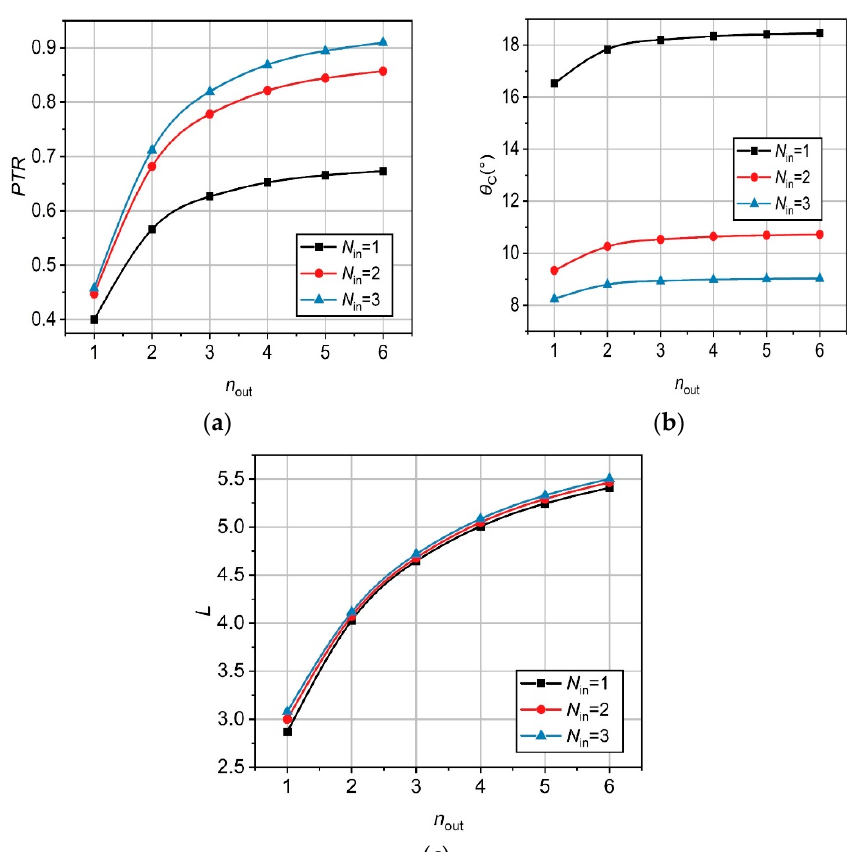
Figure 3. Influences of the number of shock waves on ( a ) the total pressure recovery; ( b ) the cowl internal angle; and ( c ) the inlet length.